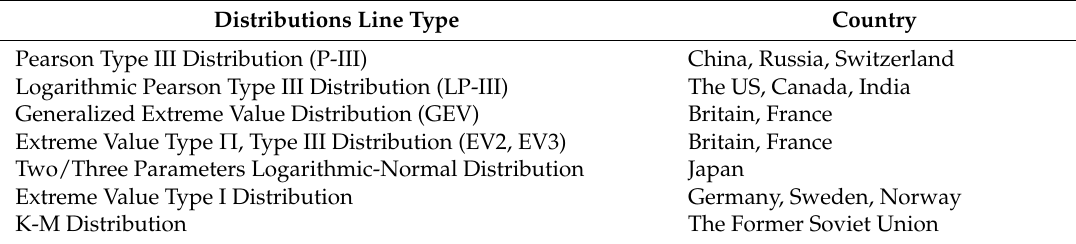
Table 16. Flood (rainstorm) probability distribution line type for the countries who use the return period as an index in their